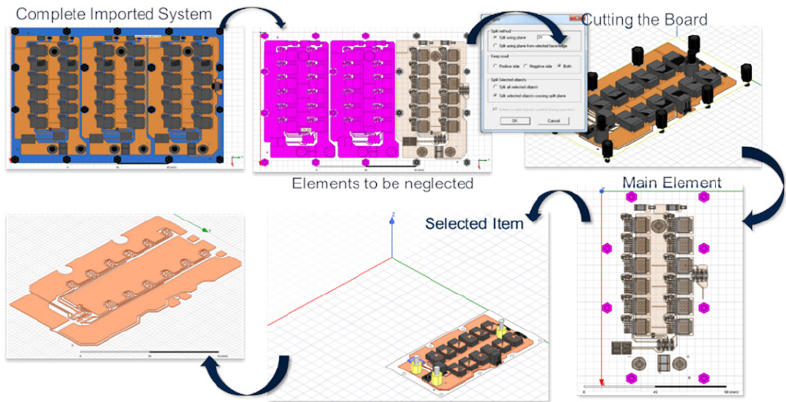
Figure 5. Steps to import the complete system